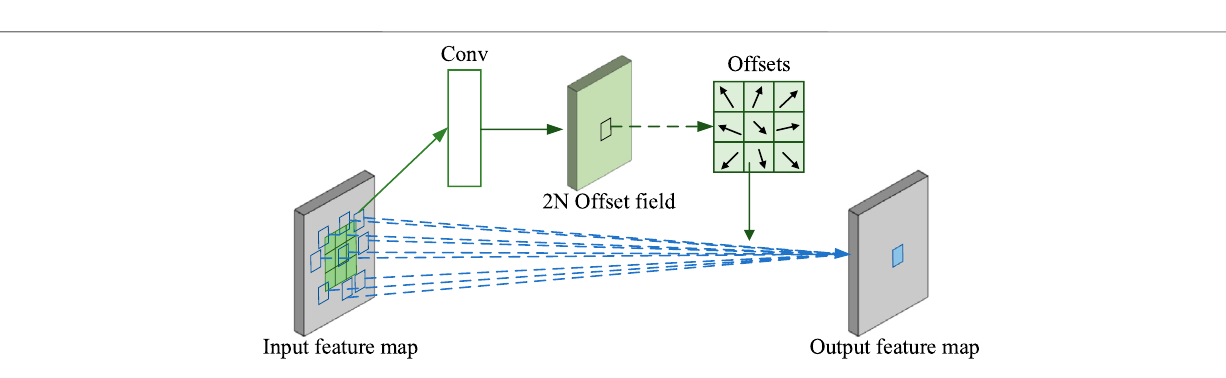
FIGURE 5 | Schematic diagram of deformable convolution.